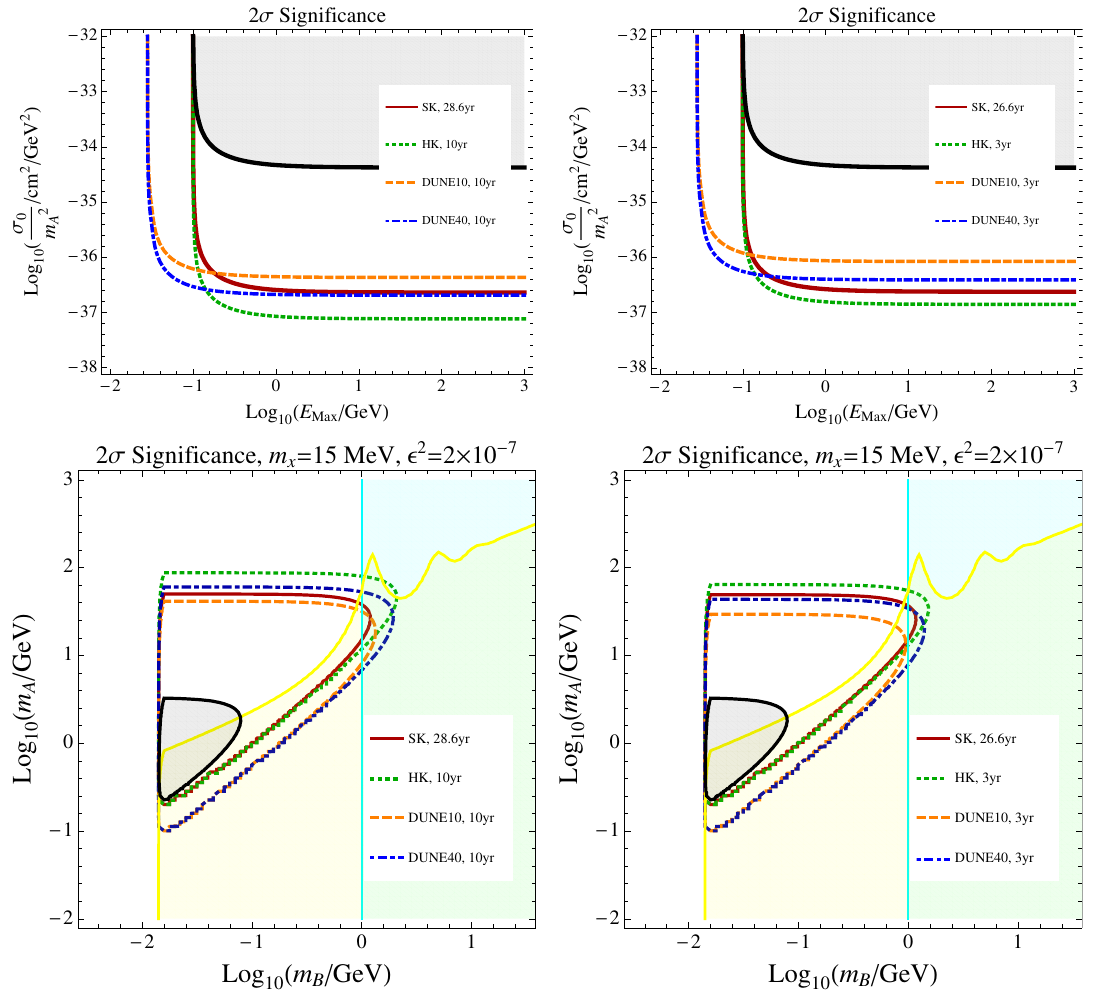
Figure 2 . 95% limits on the e(cid:11)ective cross section (cid:27) 0 (top panel) and the 2 (cid:27) signal-signi(cid:12)cance (bottom panel) assuming 5 years of construction and 10 years of physics running of DUNE (left), and 10 years of construction and 3 years of physics running of DUNE (right). The corresponding total running time of SK would be 28.6 and 26.6 years, respectively. We assume that the HK timeline is the same as DUNE. The gray-shade represents the current 2 (cid:27) exclusion with all-sky data from SK, assuming 10% systematic uncertainty in the background estimation. The other shaded areas are potential bounds from direct detection of non-relativistic B (in cyan, with vertical boundary) and CMB constraints on B annihilation (in yellow, with diagonal